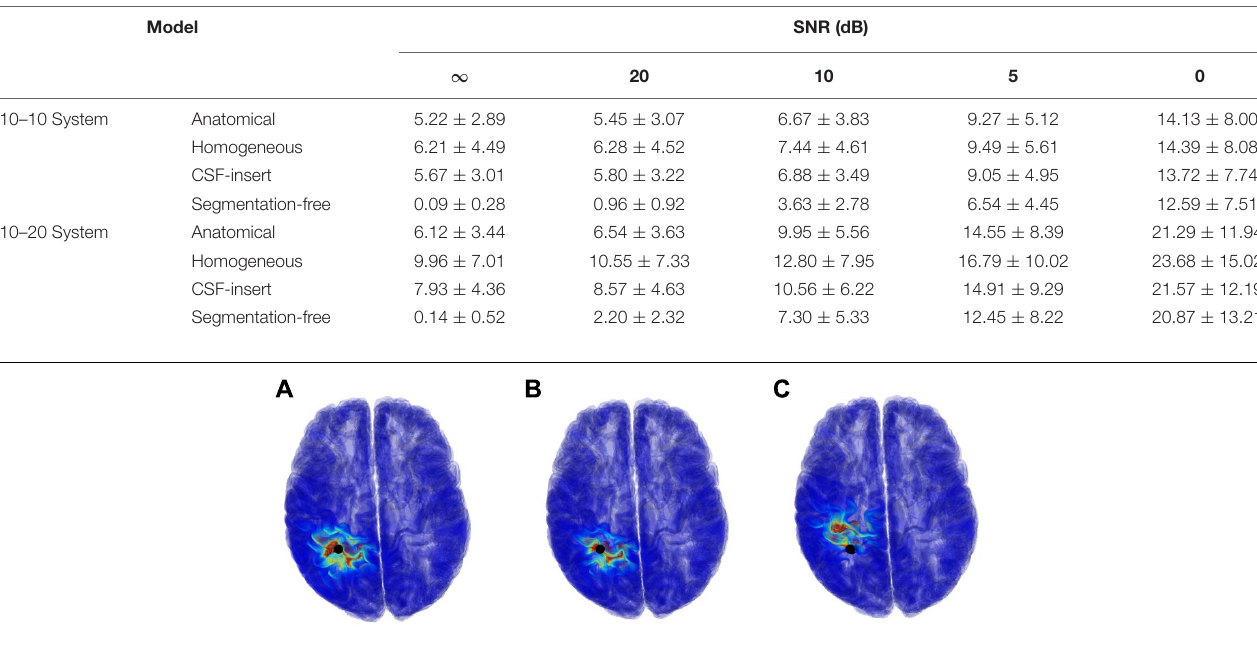
FIGURE 8 | Examples of current density distribution results, which is used segmentation free model and varying the SNR, (A) ∞ dB, (B) 5 dB, and (C) 0 dB. The black points denote true position of electric dipole.